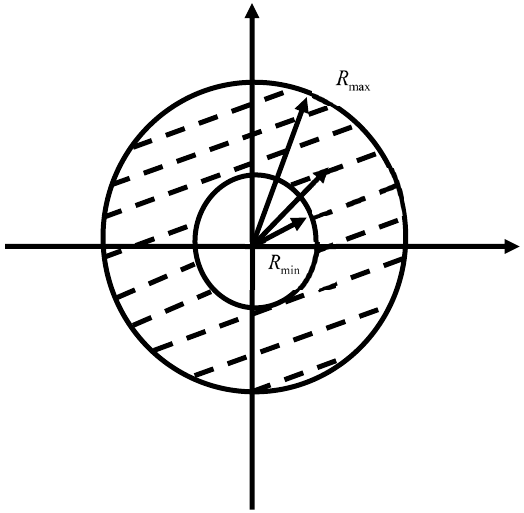
Figure 1. The area of the system’s limiting states. The value min {R} limits the area within which the limiting state of the system is impossible due to the negligibly small reaction (allowable external forces) values. 1 R — is the reaction vector of the structure determining a point inside the circles of limit states that does not lie on the line of max (min) limit states value. Starting from the value of the reactive stiffness of the system min {R} , the onset of the limiting state is possible in one or several elements of the structure. At the value of reactive stiffness max {R} , the system